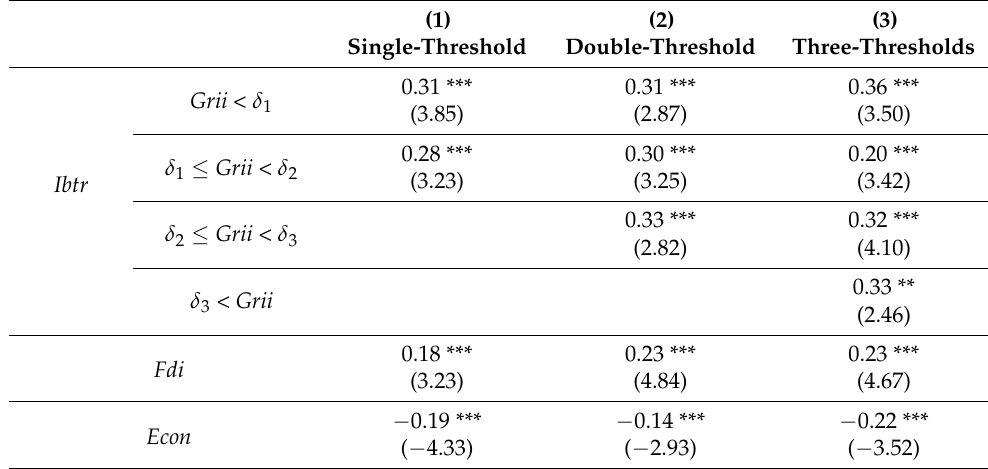
Table 6. Threshold effect results: From the perspective of green innovation factor